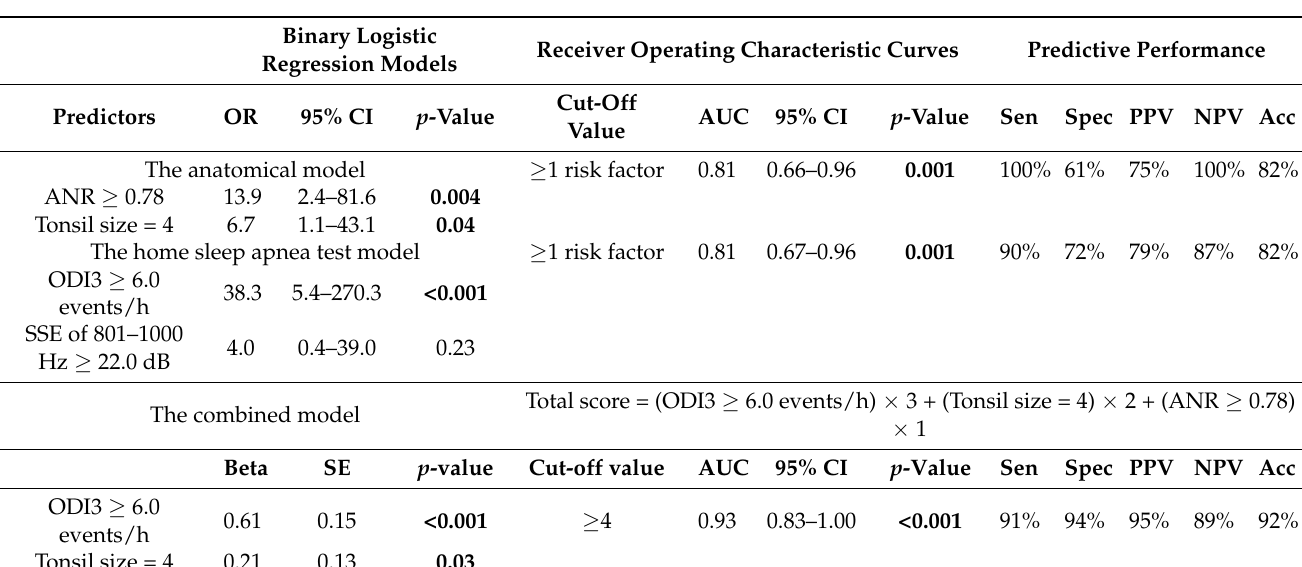
Table 4. Prediction models of severe OSA of Study 1.